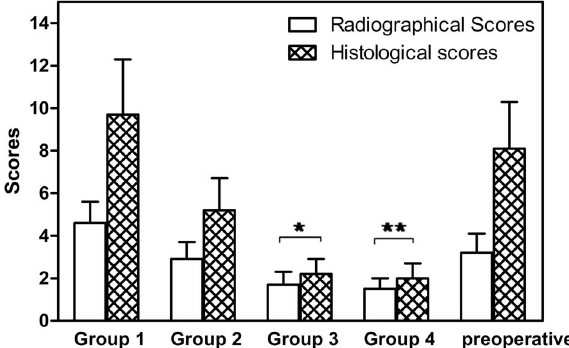
Figure 8. Radiographic scores and histological scores for rabbit tibiae infected with osteomyelitis prior to treatment (pre- operative) and after 8 weeks of treatment in the 4 groups. Group 1: no treatment; Group 2: intravenous injection of vancomycin; Group 3: vancomycin- loaded CS cement; Group 4: vancomycin-loaded borate BG cement. (mean 6 SD; *, ** significantly different to the corresponding scores for the other groups, P , 0.05).